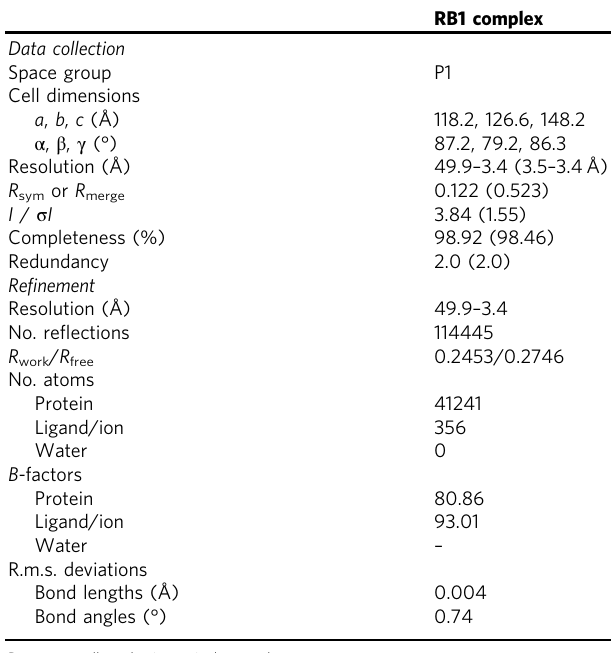
Table 2 Data collection and re fi nement statistics (molecular